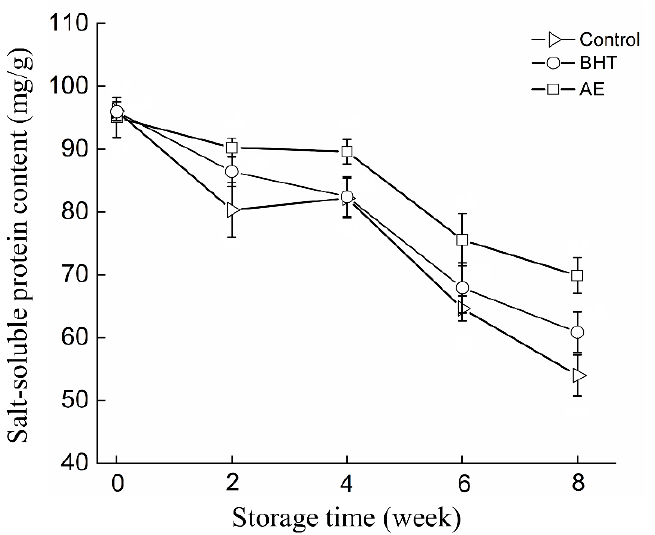
Figure 3. Changes of salt-soluble protein content of shrimp surimi products treated with AE, BHT, and control during frozen storage.